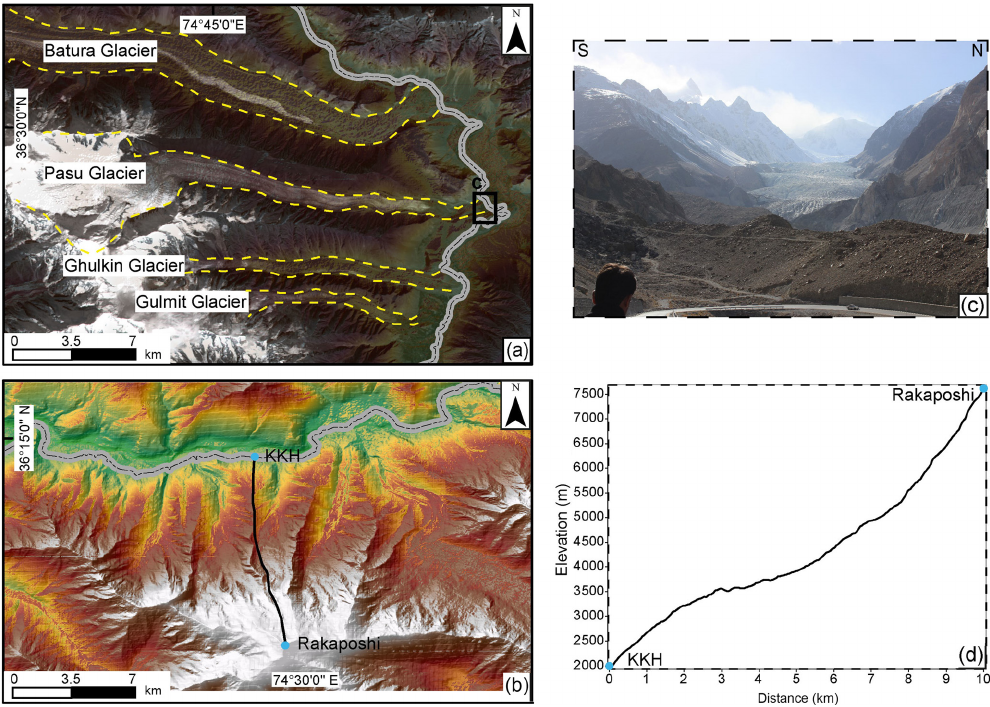
Figure 2. (a) Glaciers along the KKH. (b) Relief along the KKH. (c) Pasu Glacier’s snout approaching the KKH. (d) Profile drawn along axis drawn in Fig. 2b: elevation drops from 7788 to 2000m over a horizontal distance of 10km.